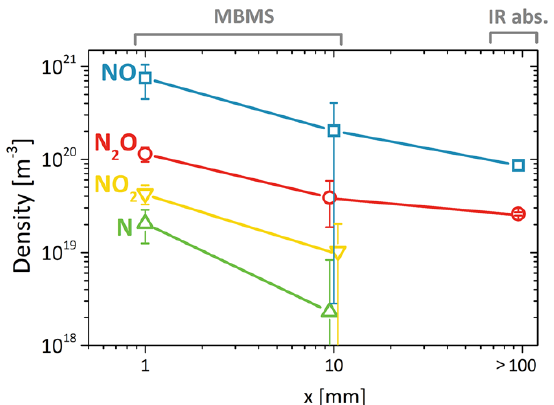
Figure 21. Comparison of absolute densities of nitrous species from the μ -APPJ obtained by molecular beam mass spectrometry (MBMS) (for x = 1 and 10 mm) and IR absorption (>100 mm) for a ratio of He/N 2 /O 2 = 99.58/0.35/0.07 at 1.4 slm gas flow. The connecting lines are to show the reader the different decay constants of the species [65], © IOP Publishing. Reproduced with permission. All rights